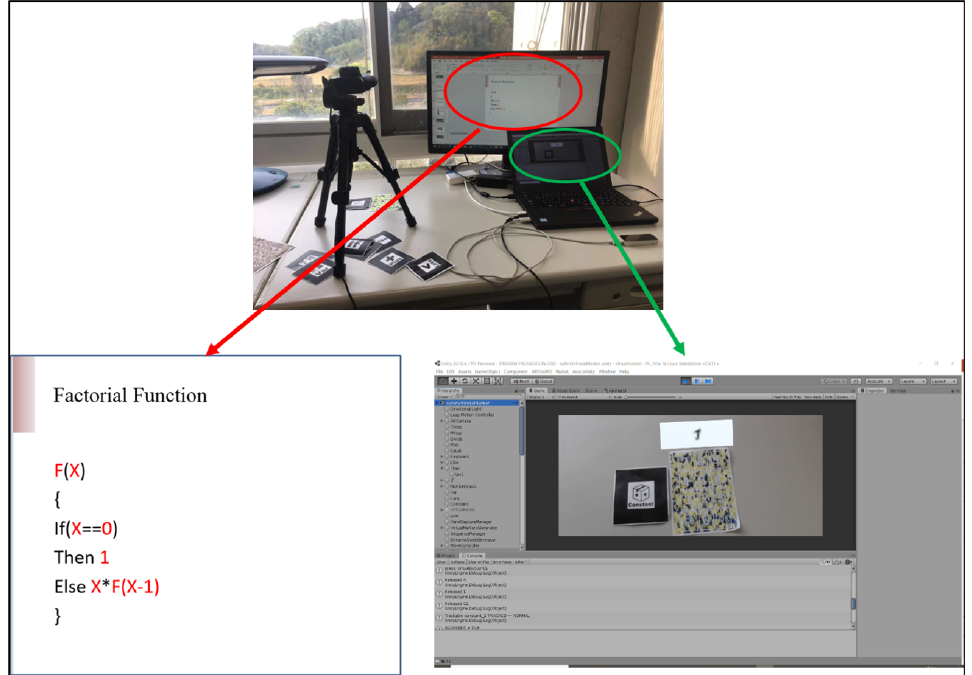
Figure 14. Experimenter scene. The experimenters were provided with two screens. One screen showed the task that they needed to complete, while the other screen was available for them to use the system. Other equipment in the experimental scene included a camera, a PC, leap motion, and some